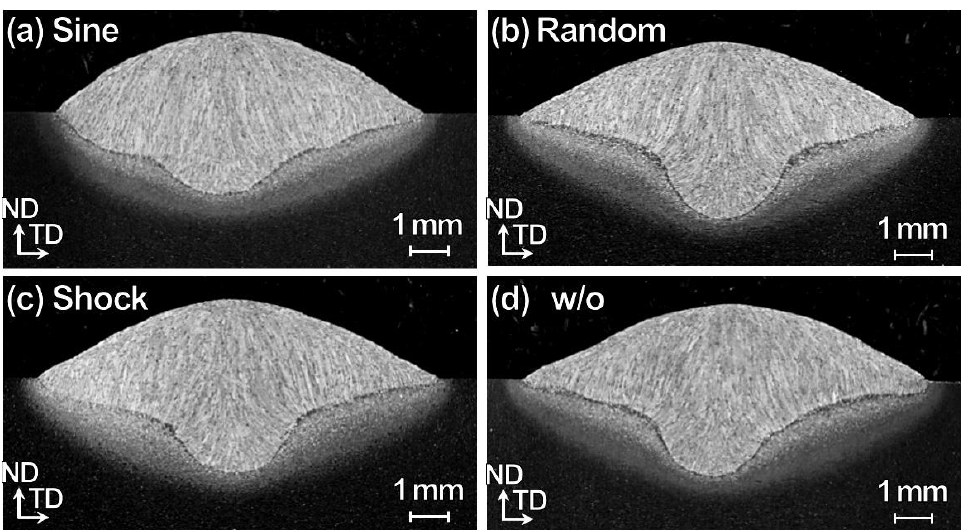
Figure 10. Cross-sectional OM images for TP-GMAW specimens at 1.2 m / min w / three-mode vibration modes including ( a ) sine, ( b ) random, and ( c ) shock modes (F = 250 Hz, G = 1.2 m / s 2 and T = 30 s), together with that of ( d ) w / o vibration, for comparison.